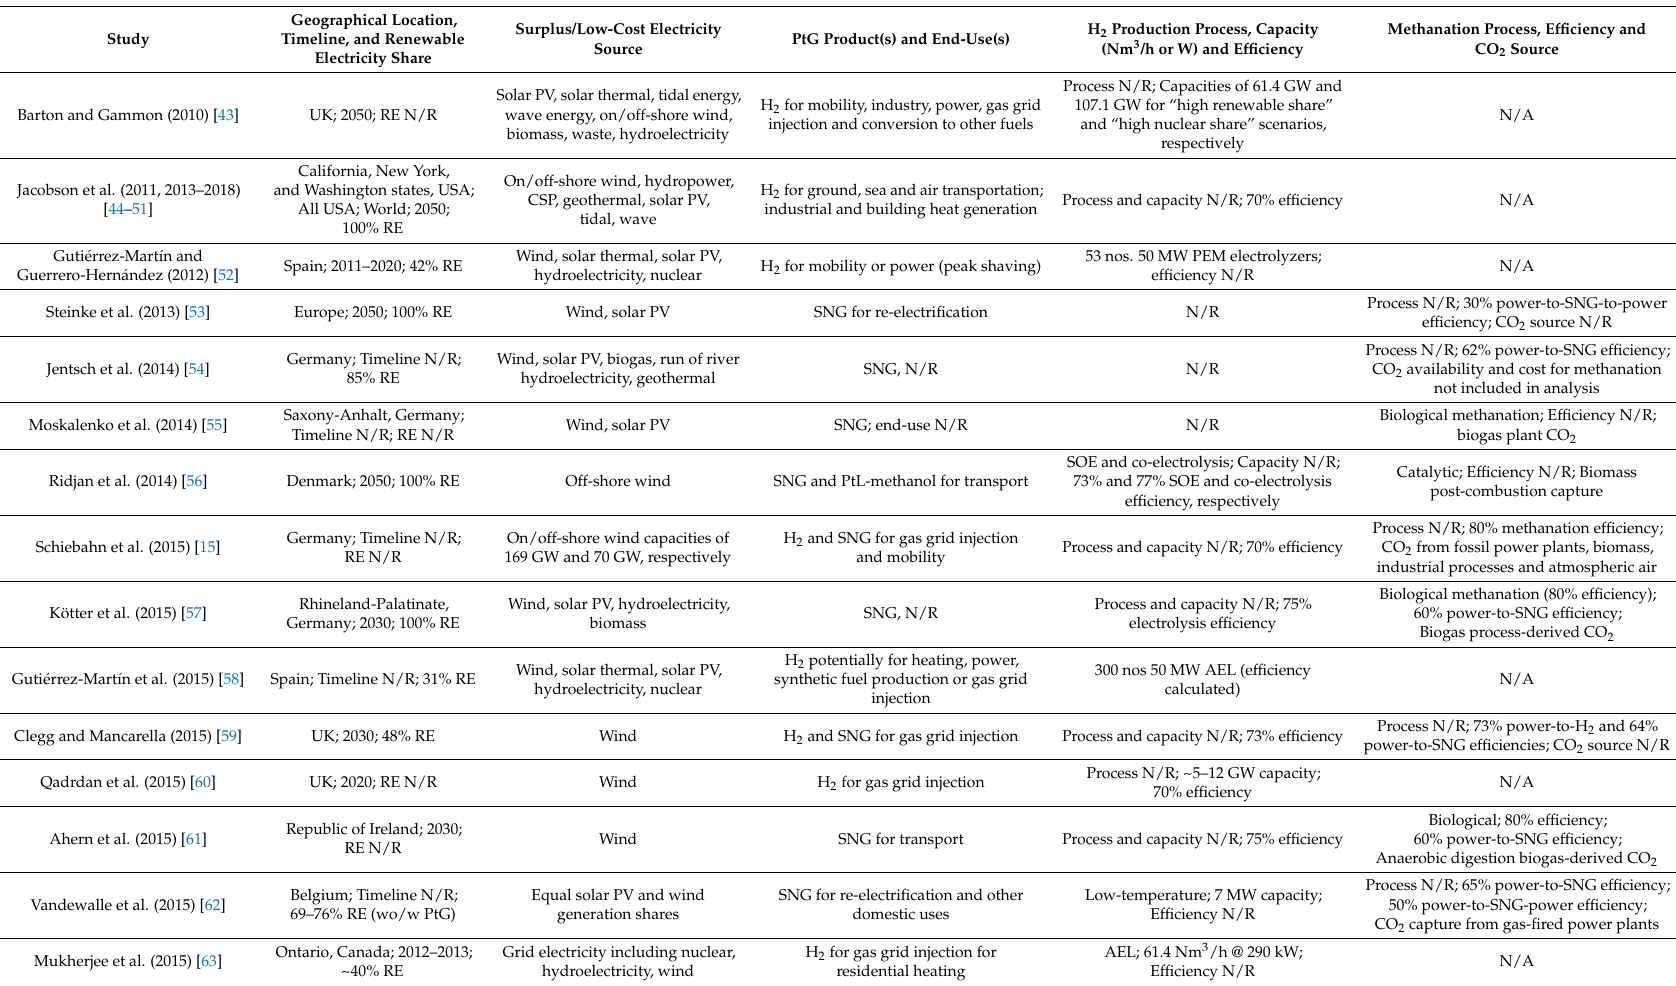
Table 1. Summary of published analyzes of PtG deployment scenarios at regional- and national